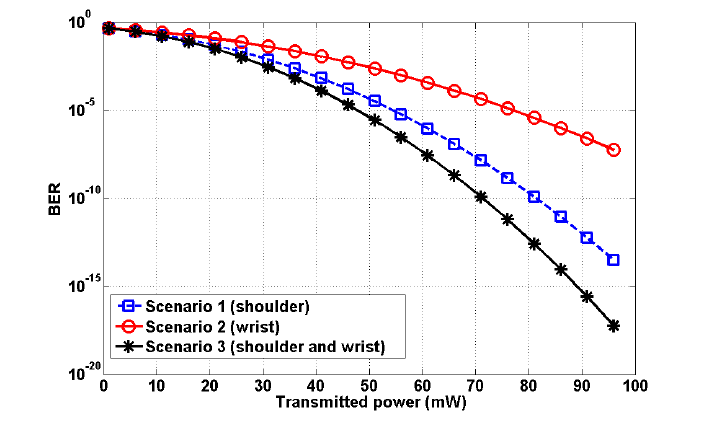
Figure 8. Performance analysis relative to transmit